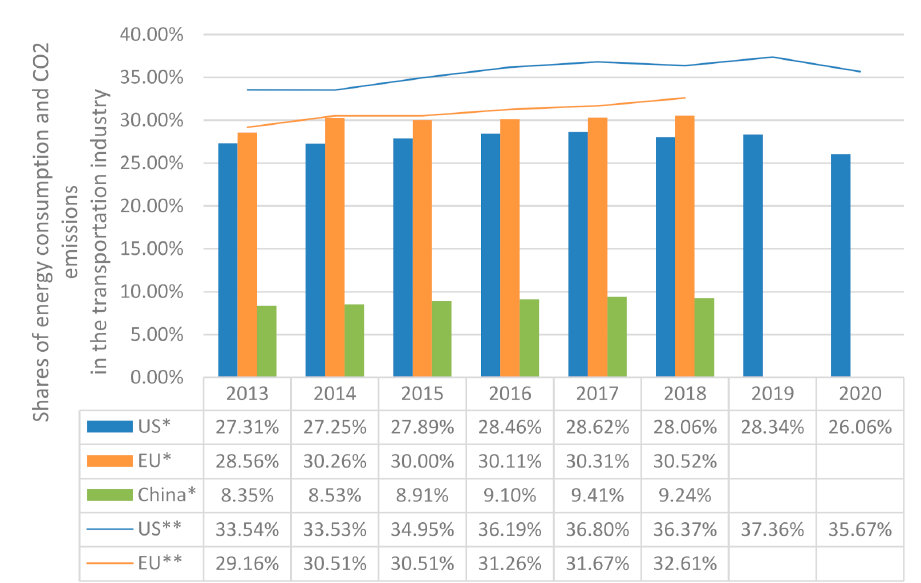
Figure 1. Shares of energy consumption and CO 2 emissions in the transportation industry in the United States, China, and the European Union. Symbols for this figure: * shares of energy consumption, ** shares of CO 2 emissions. Vacant data means not